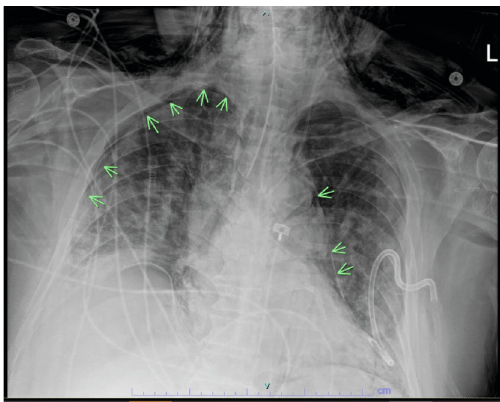
Figure 4: CXR showing persistent right-sided pneumothorax, pneumomediastinum, and the supraclavicular di ff use subcutaneous emphysema with a bilateral chest tube.